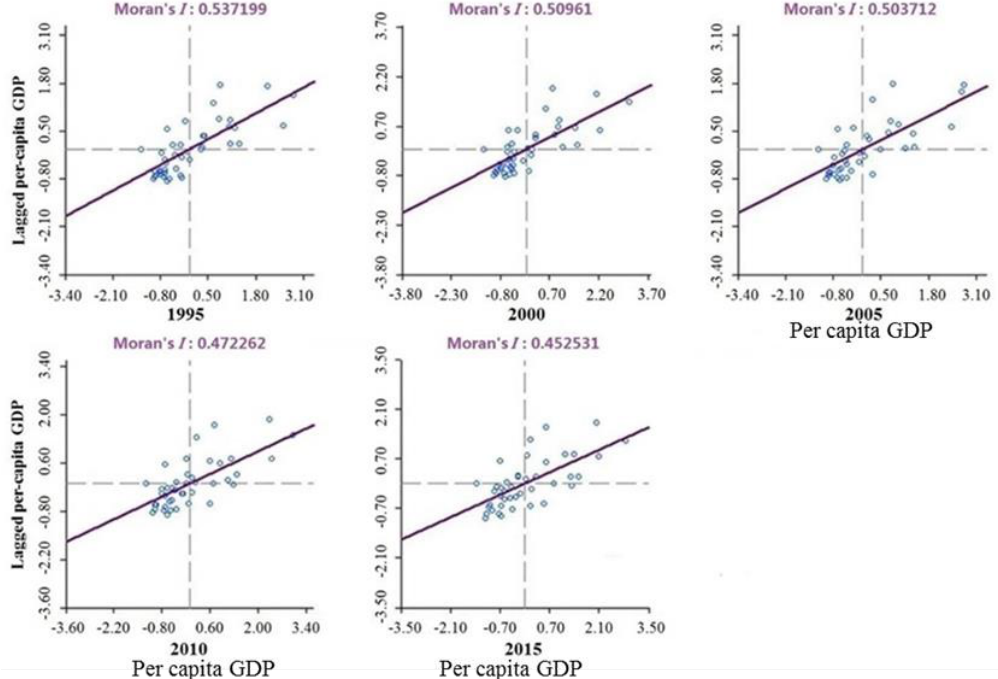
Figure 5. Moran’s I scatter plots in the YRD region from 1995 to 2015.